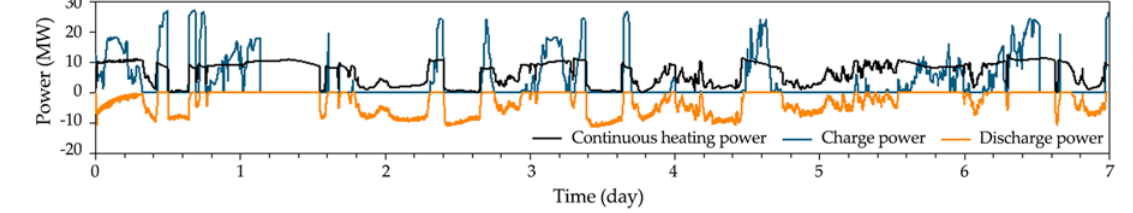
Figure 11. Simulated result of the input powers for storage and DH.